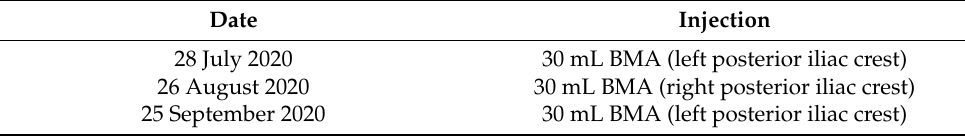
Table 3. Orthobiologic treatment design.